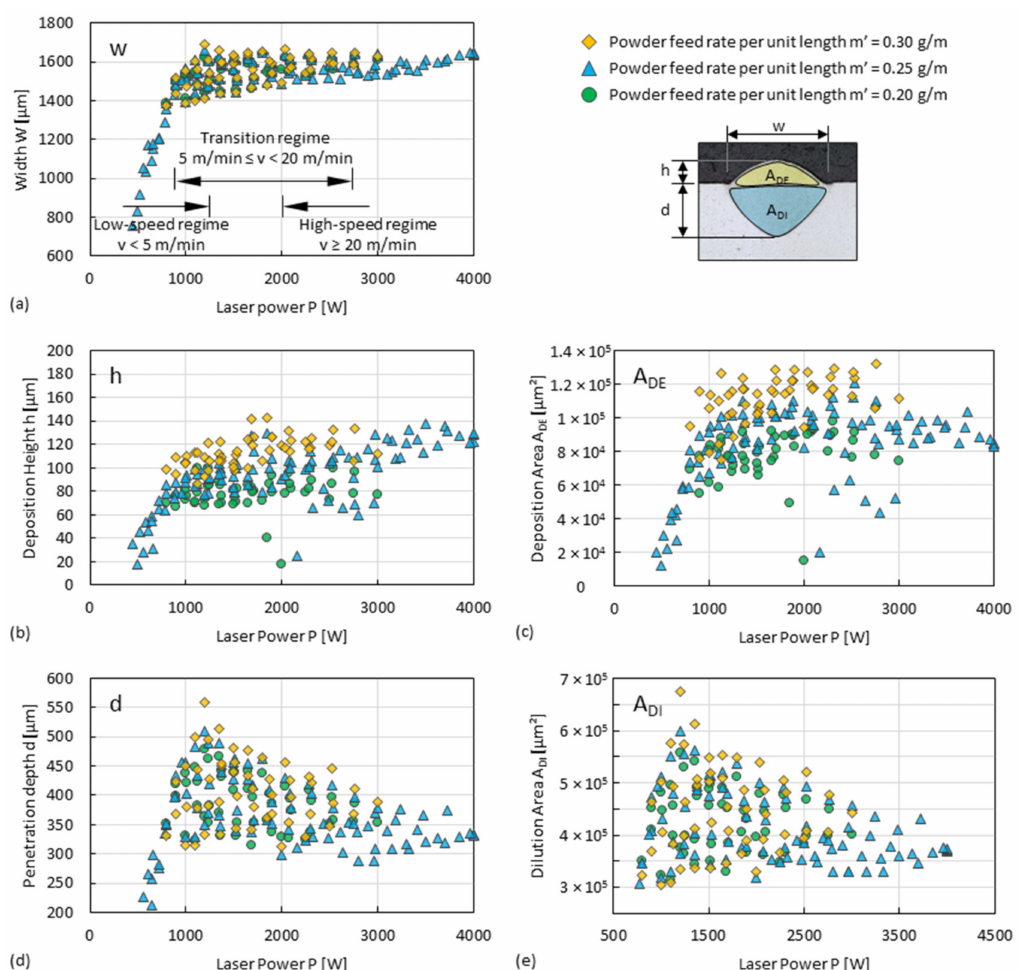
Figure A1. Plot graphs of the data shown in Figure 8 and supplementary data of “low-speed regime” (also see Figure 19) of ( a ) track width w , ( b ) track height h , ( c ) cross-sectional area of the deposition zone A DE , ( d ) melt pool depth d , and ( e ) cross-sectional area of the dilution zone A DI against laser power P with different powder feed rate per unit length m’ . Every point refers to the average value of three measurements. The corresponding travel speeds are marked in ( a